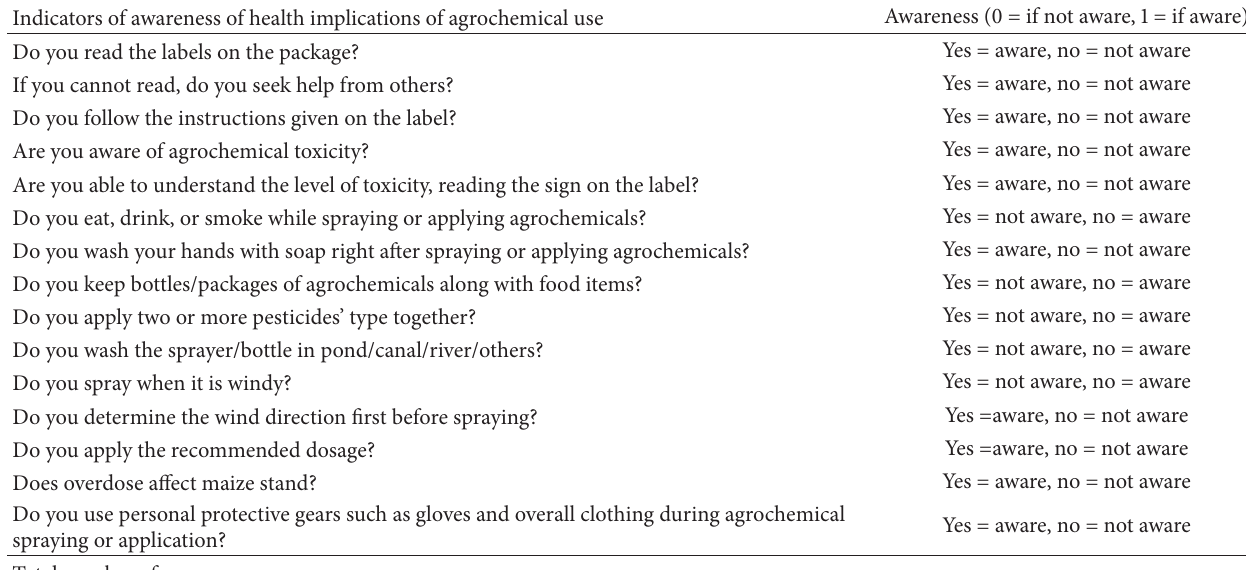
Table 7: Indicative questions for measuring awareness of health implications of agrochemical use. Indicators of awareness of health implications of agrochemical